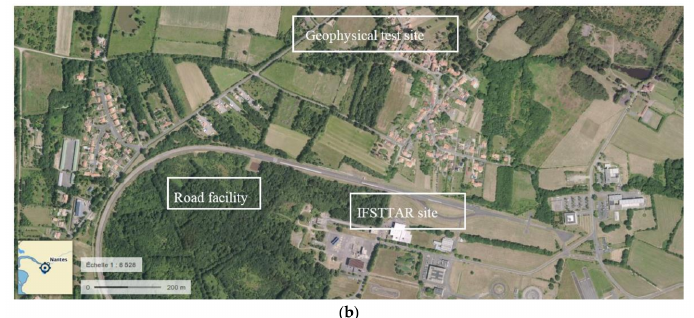
Figure 1. Geographical position of the IFSTTAR geophysical test site. ( a ) Map of France, where the the test site location is indicated; ( b ) Aerial photo (taken from the website of the French Ministry ‘Minist è re français de la Transition É cologique et Solidaire’, www.geoportail.gouv.fr/carte) showing the test site area.